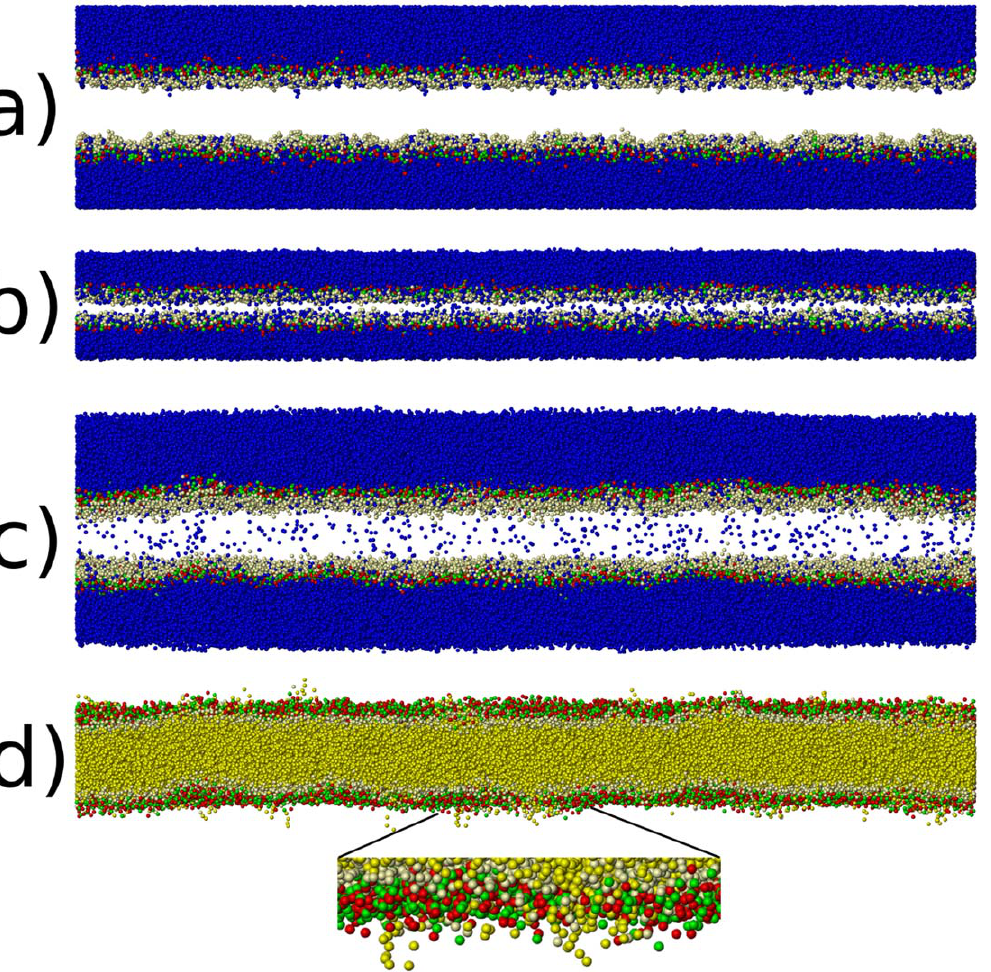
Figure 10. Simulation snapshots for the shock experiment with v p ~ 2045 m/s. Structure a) shows the initial equilibrium configuration at 310 K and 1 atm. Only water (blue) and the hydrophilic head groups of the lipids (red, green, and beige) are shown. The hydrophobic tails of the lipids are not shown in order to facilitate the visualization of water within the lipid bilayer. b) shows the state at maximum compression. c) shows the unloaded state after 2500 ps. Note the amount of water introduced into the bilayer. d) also shows the final state after unloading, but here only lipids with their tails (yellow) are shown but no water. Note that some lipid have turned around and now point into the water with their hydrophobic tails, a feature not present in the equilibrium structure (cf. Fig.